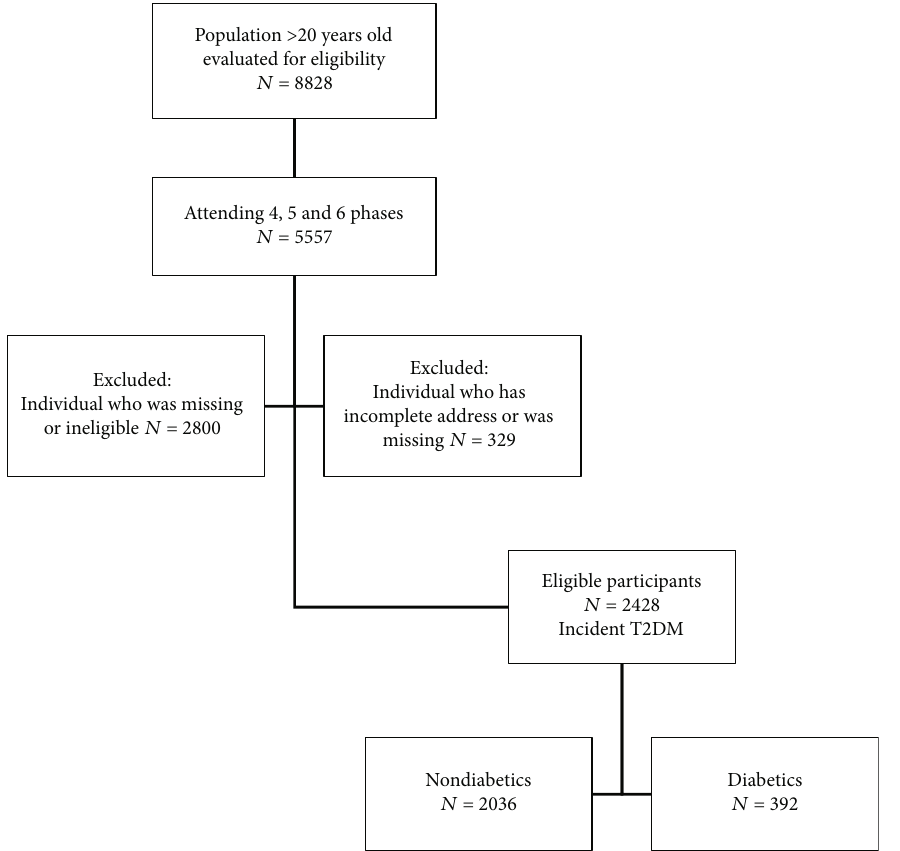
Figure 1: Flow diagram of the study design and participants in the TCGS